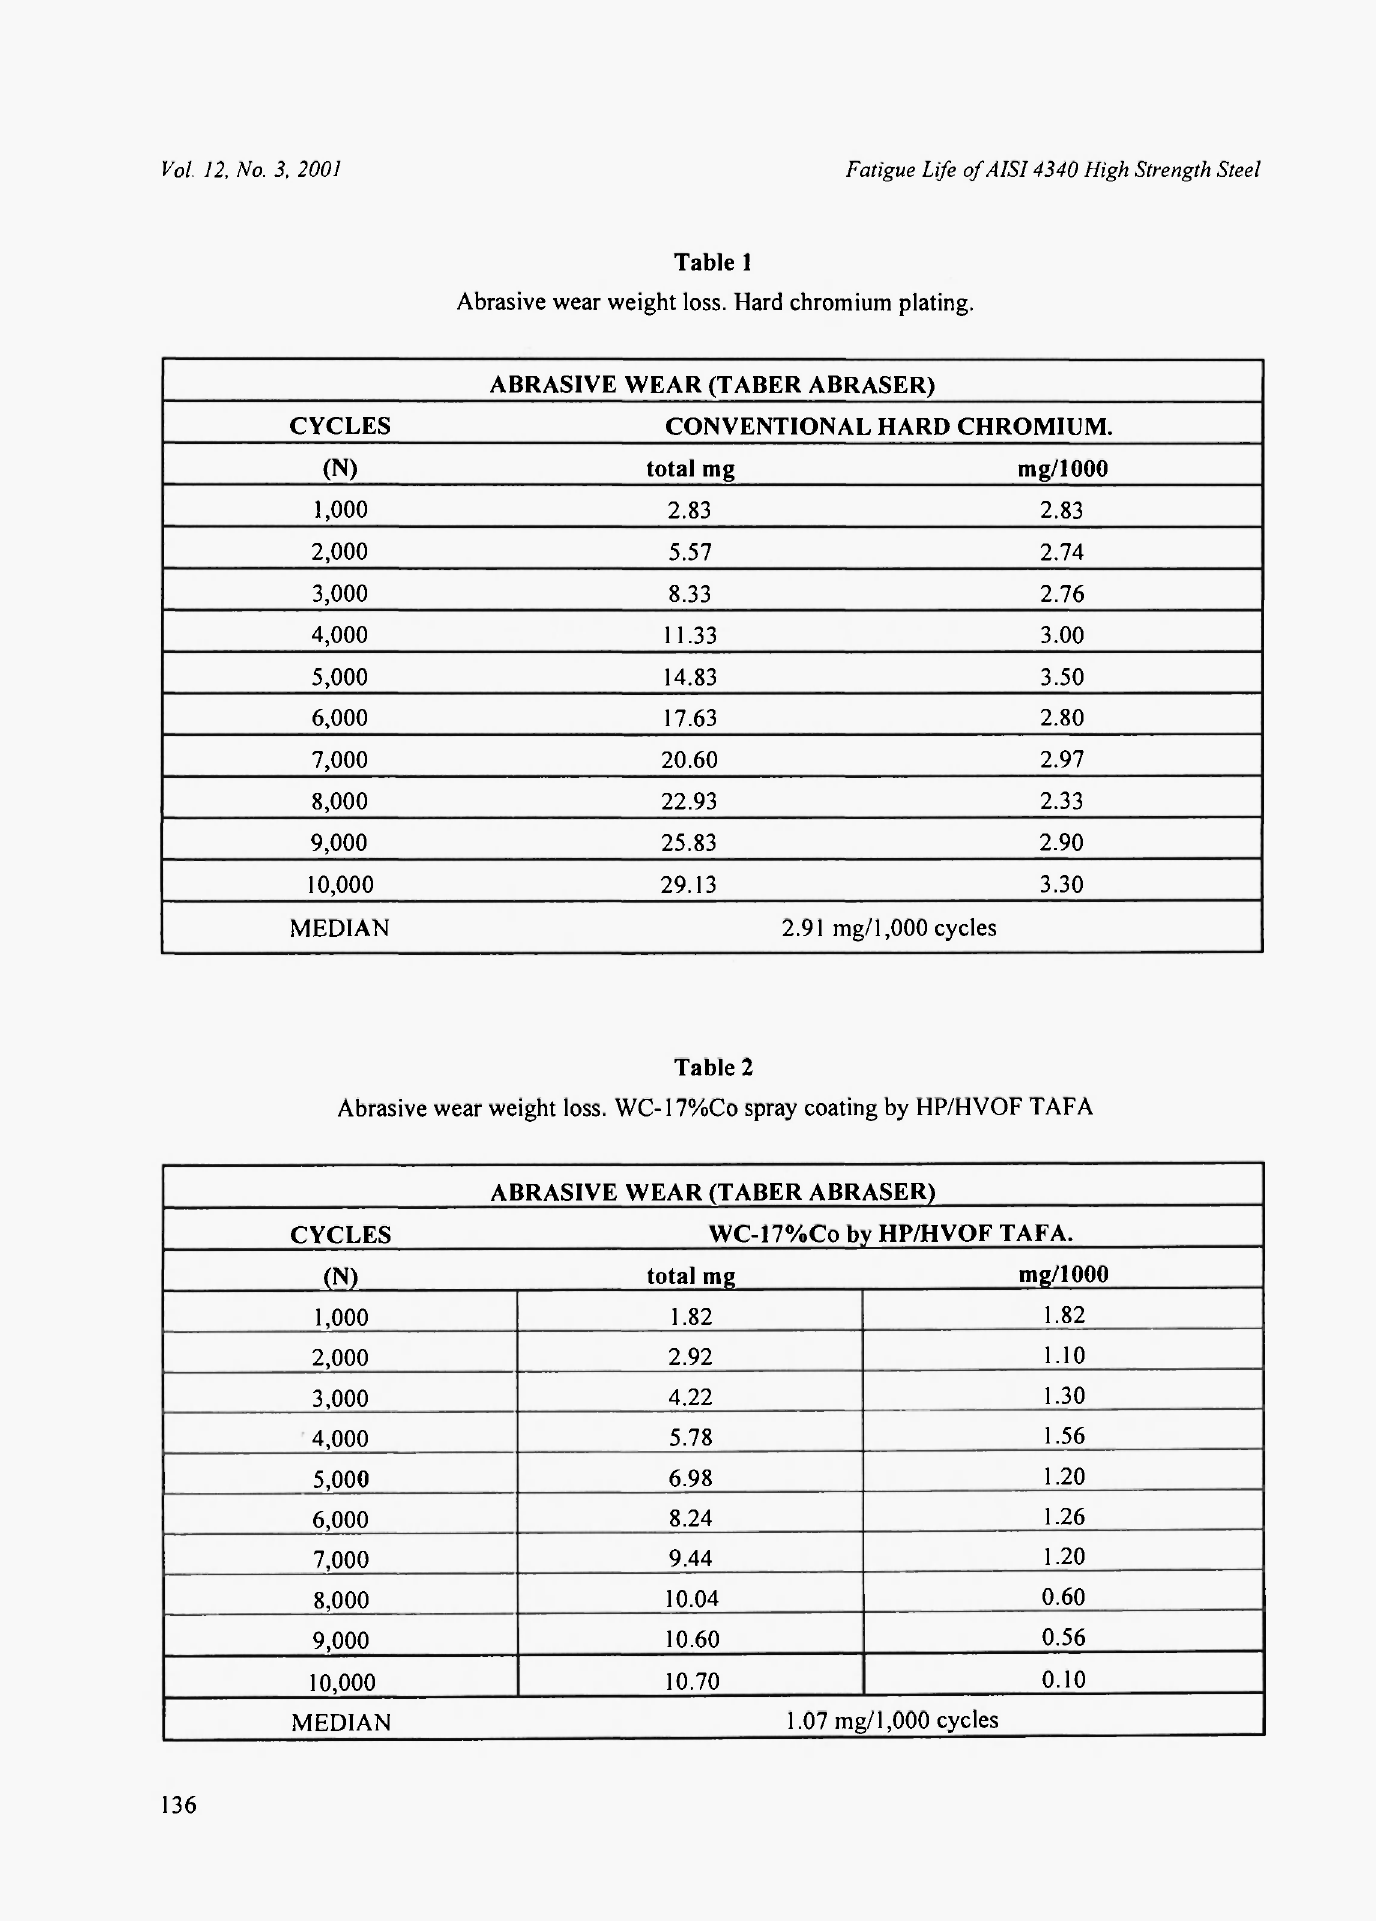
Abrasive wear weight loss. WC-17%Co spray coating by HP/HVOF